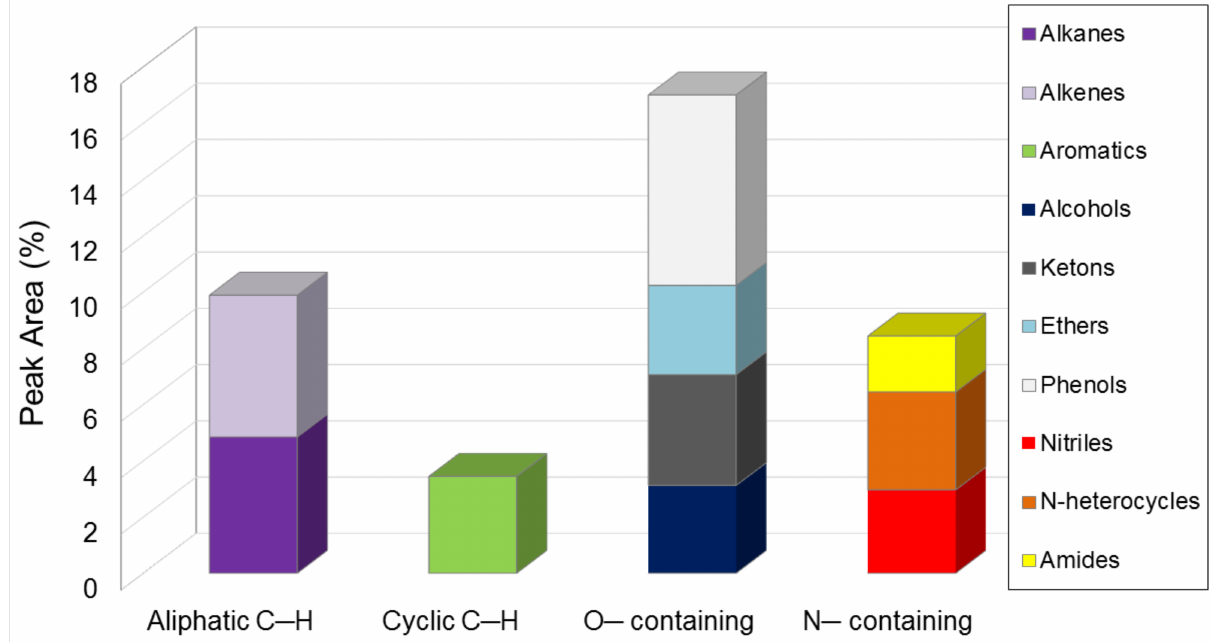
Figure 6. Chemical composition of the oil fraction from inflorescences. There were marked changes in the composition of the oil fraction obtained from in- florescences relative to the composition of the oil fraction obtained from leaves. The main mass fraction of all identified compounds here is represented by an oxygen-containing group of substances (17%): alcohols (3.12%), ketones (3.94%), ethers (3.17%), and phenols (6.77%). At the same time, the proportion of phenols increased markedly. The content of aliphatic hydrocarbons decreased to 9.88%, mainly due to a decrease in the content of paraffinic hydrocarbons to 4.84%. The fractions of hydrocarbons also changed: paraf- finic (C 16 –C 44 ) and olefinic (C 14 –C 30 ), respectively. Cyclic hydrocarbons make up 3.44%. Nitrogen-containing compounds account for 8.43%, of which less than half are heterocycles